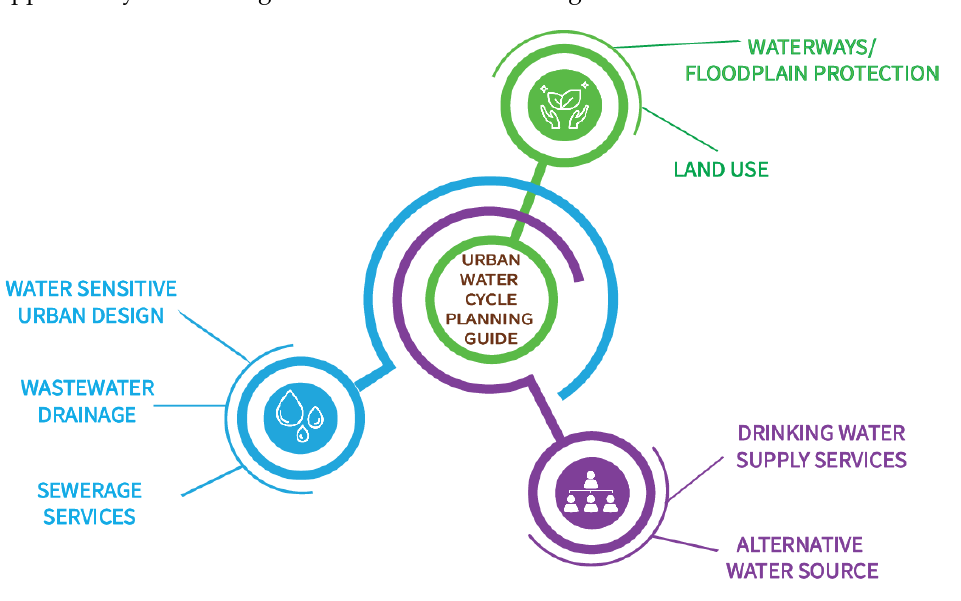
Table 1. Comparison of IWCM interpretations in the STEEPI framework.